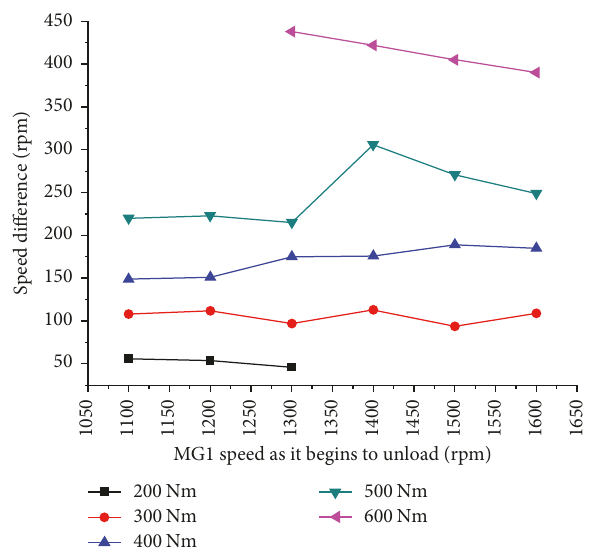
Figure 12: The curves of 𝜔 raw MG 1 and Δ𝜔 MG 1 under different 𝑇 𝑇 MG 1 .